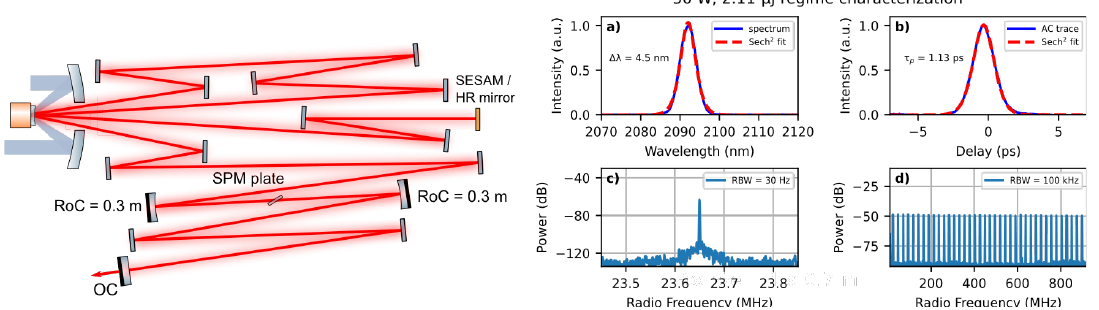
Fig. 1 Laser resonator used for high power modelocking experiment and a) modelocked laser spectrum, b) autocorrelation trace, radio-frequency spectra of the regime depicting c) the first beatnote, d) the harmonics in a 900 MHz span. RBW stands for resolution